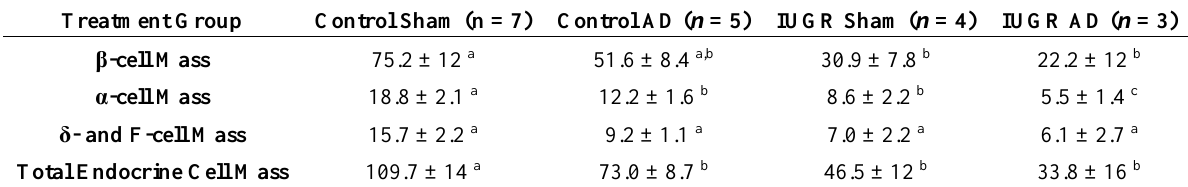
Figure 4. Pancreatic endocrine cell areas. Insulin positive area ( A ); glucagon positive area ( B ); and the combined somatostatin and PP positive area ( C ) were measured and the mean percent area of the pancreas tissue graphed for the treatment groups labeled on the x-axis. Error bars represent the SEM and different superscripts denote statistically significant differences among treatment groups ( p < 0.05). Table 2. Mean (±SEM) endocrine cell mass (mg) for treatment groups.